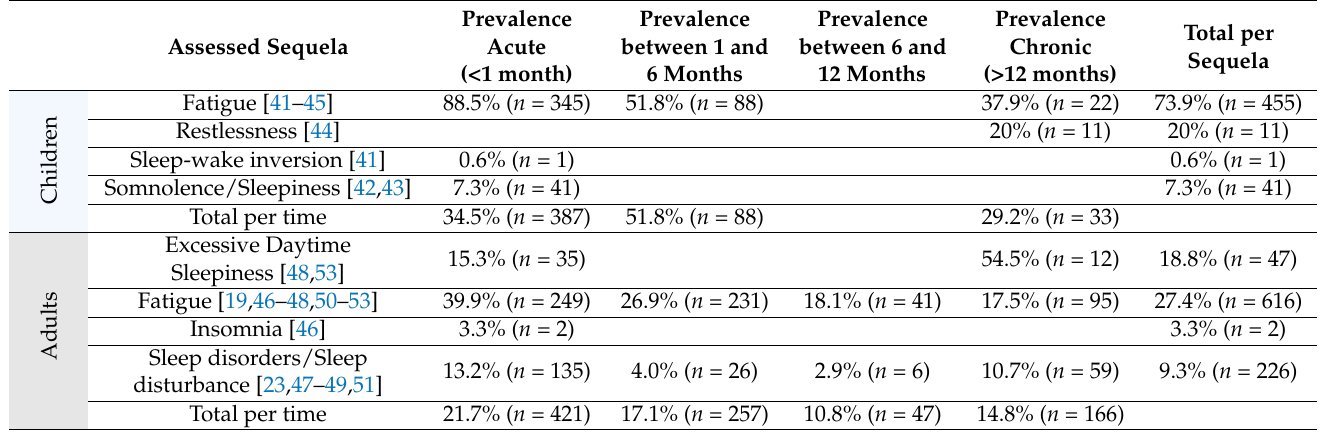
Table 3. Prevalence for each sequela per timepoint with synonyms